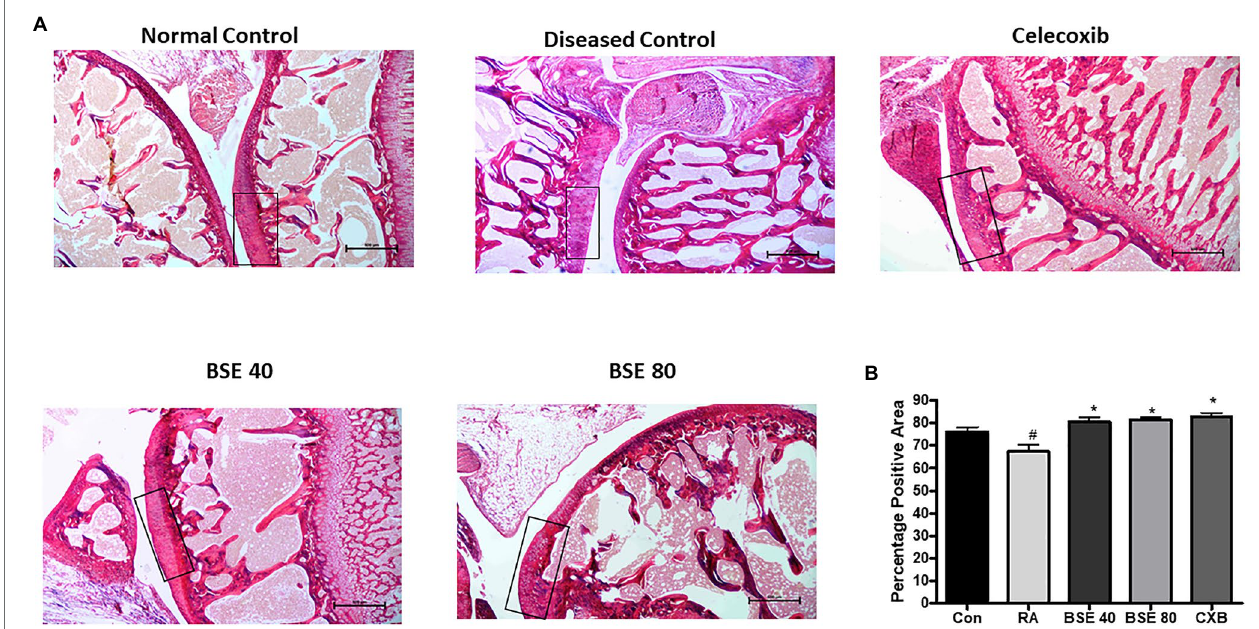
FIGURE 7 | (A) Picrosirius stained images of ankle joint. (B) Percentage positive area out of total tissue area. The box represents the intact collagen, which is degraded in the CIA control. BSE 40 and BSE 80, Boswellin. Super Extract 40 and 80 mg/kg; CXB, celecoxib 10 mg/kg; and RA, CIA control. * p < 0.05 compared to RA animal; # p < 0.005 compared to